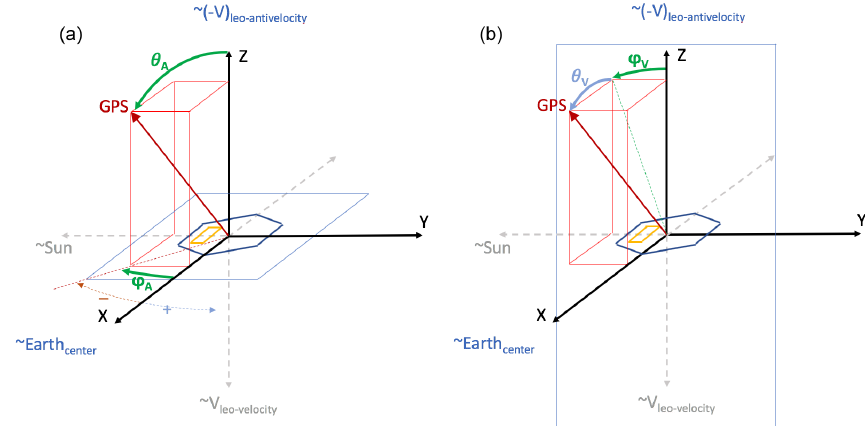
Figure 4. Graphical sketch of the reference frames defined in the text. The same x , y , and z axes (fixed in the satellite body frame) are used to define both reference frames. (a) Antenna reference frame: the principal plane where the location of the GPS satellite is evaluated is the x – y plane, emphasized by a thin blue line; (b) velocity reference frame: the principal plane where the location of the GPS satellite is evaluated is the y – z plane, emphasized by a thin blue line. The approximate directions at which the different axes point to are specified for reference for the reader.